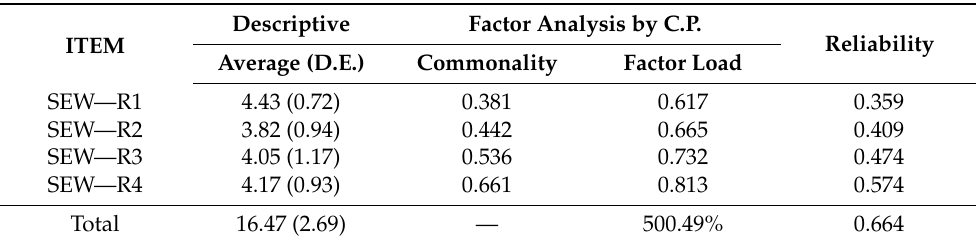
Table 2. Unidimensionality and reliability. Dimension: R—Renewal of family ties through succession of the REI ( n = 156).